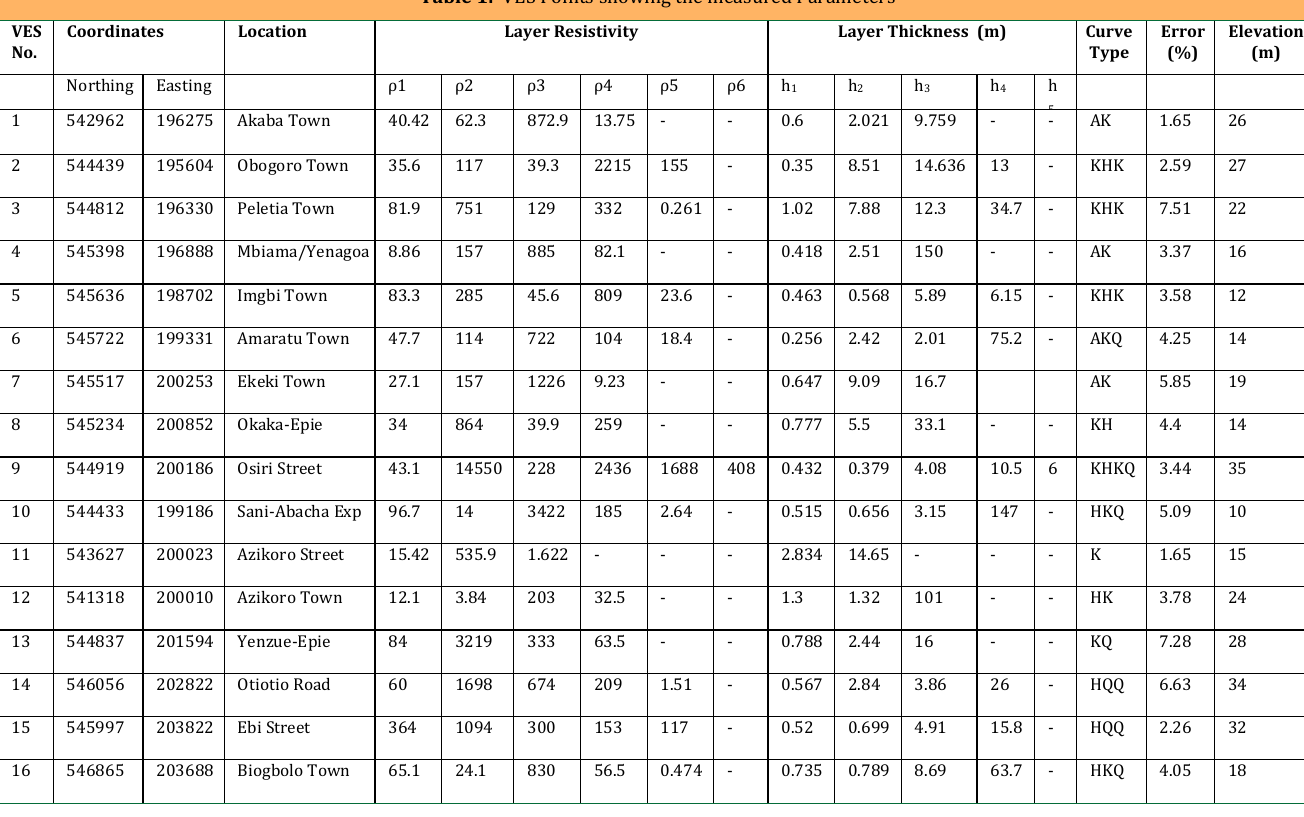
Table 1: VES Points showing the measured